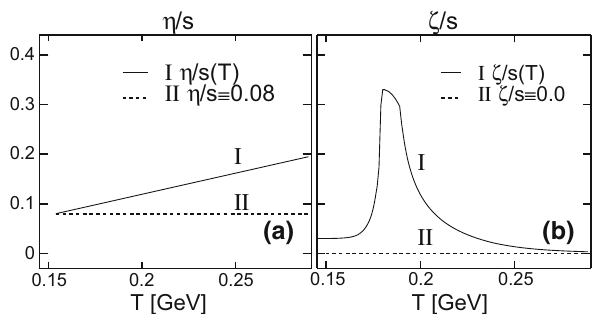
Fig. 1 Two sets of specific shear viscosity η/ s and specific bulk vis- cosity ζ/ s asafunctionoftemperature,usedin iEBE-VISHNU simula- tions with TRENTo initial condition (para-I) and AMPT initial condition